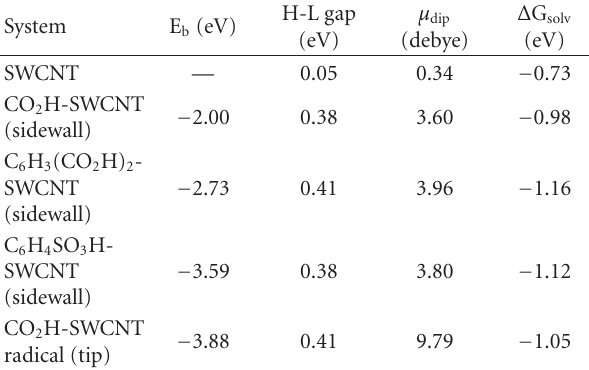
Table 1: Electronic properties for the C 60 H 20 nanotube and the functionalized SWCNT formed in the reactions (3)–(6). The properties are HOMO-LUMO gap (H-L gap), magnitude of the dipole moment ( µ dip ), and the Gibbs free energy of solvation ( Δ G solv ).